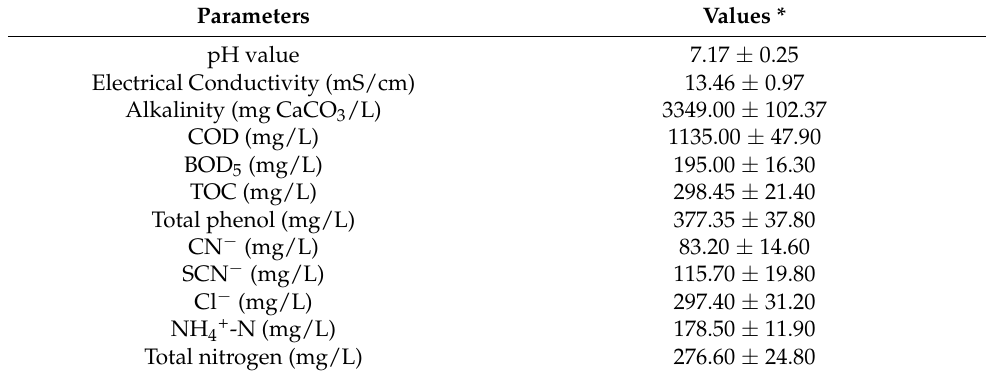
Table 3. Physicochemical properties of the coking